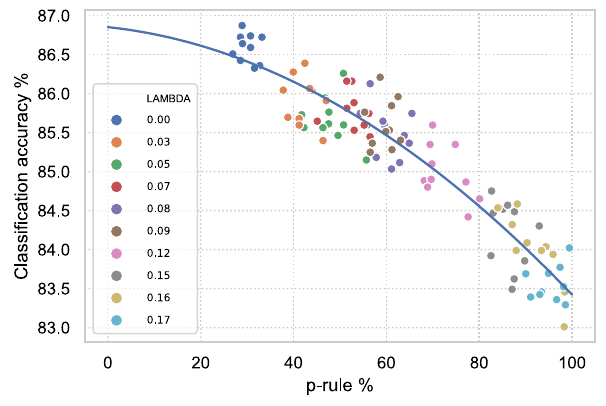
Fig. 4 Impact of hyperparameter 𝜆 (Adult UCI data set): higher val- ues of 𝜆 produce fairer predictions, while 𝜆 near 0 allows to only focus on optimizing the classifier predictor